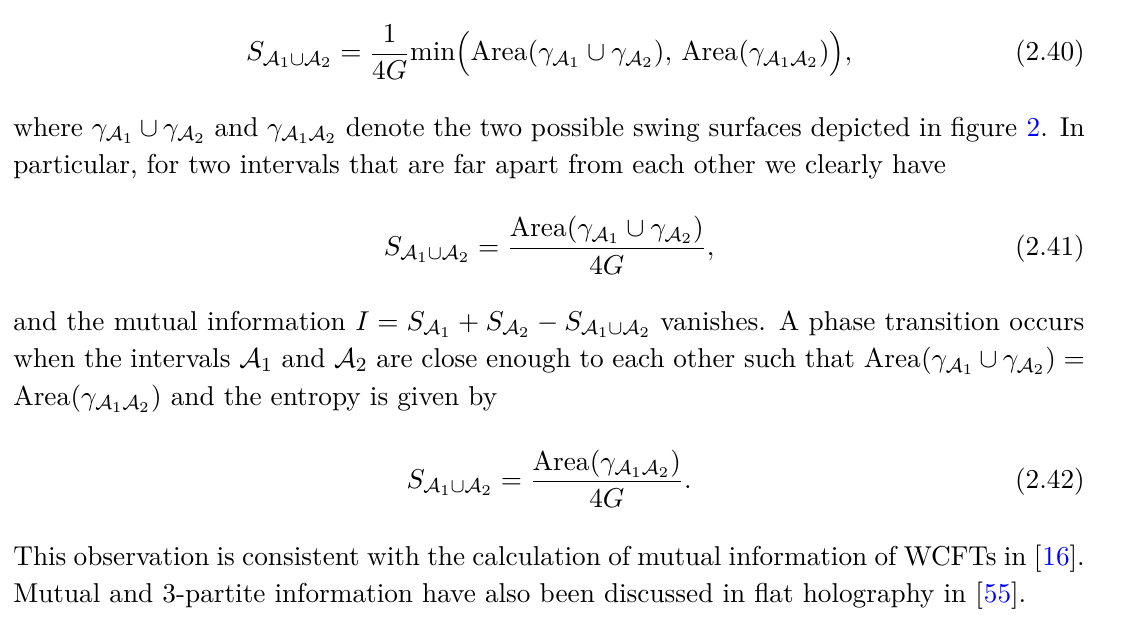
Figure 2 . Two-dimensional sketch of two competing swing surfaces γ A gous to the disjoint union of two intervals A 1 and A 2 . The dotted lines denote the ropes while the solid lines denote the